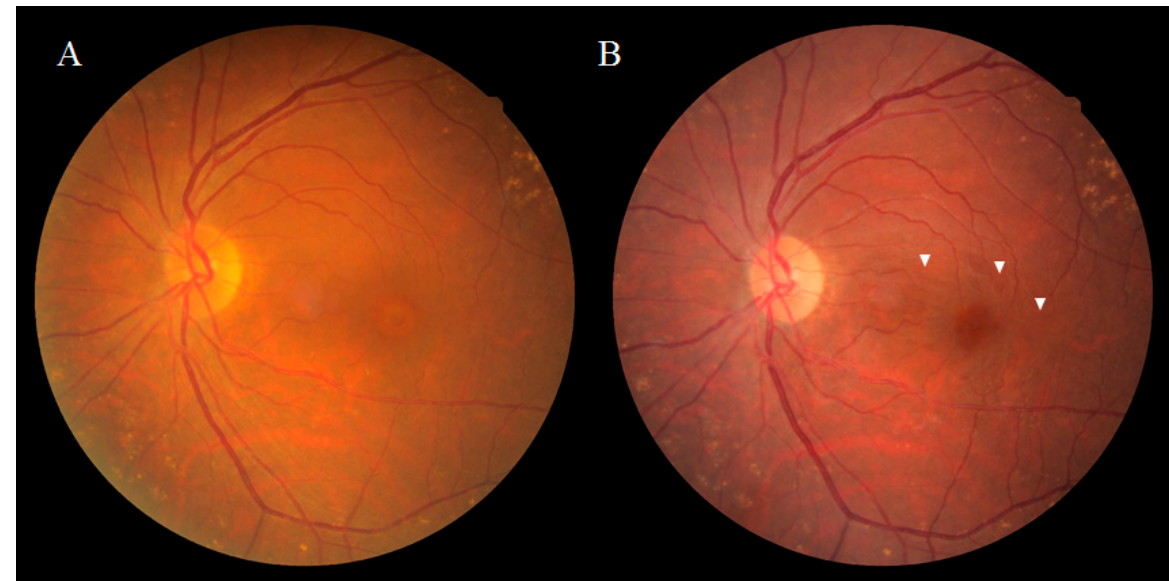
Figure 1. Fundus photograph of a patient obtained pre ( A ) and post ( B ) vitrectomy surgery for an idiopathic macular hole (MH). Ophthalmoscopically, the dissociated optic nerve fiber layer (DONFL) appearance features arcuate striae color changes, which appear to be multilinear shaped, that are frequently observed in the macular nerve fiber layer (( B ), white arrowheads).